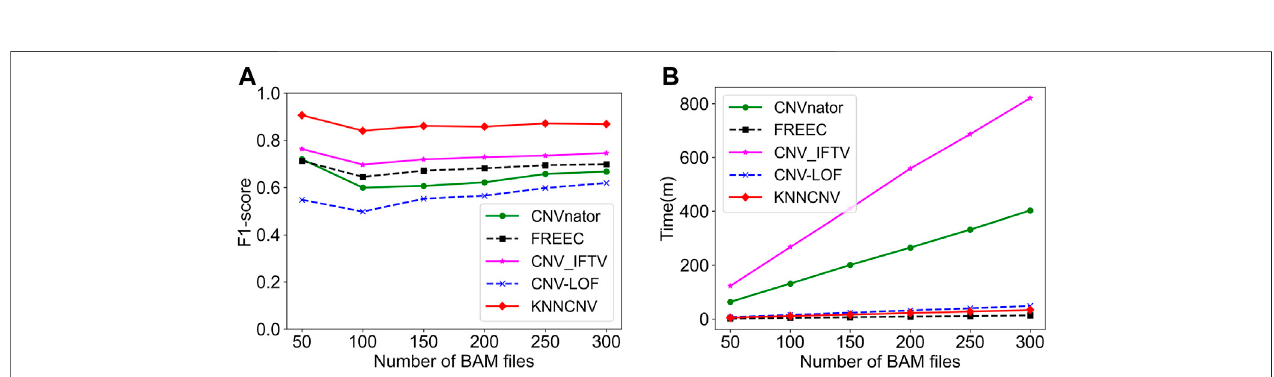
FIGURE 4 | Comparison of the KNNCNV with four peer methods on the simulated datasets in terms of F1-score and computational cost. (A) Performance of the fi ve methods with different the number of BAM fi les. (B) Variation of running time of the fi ve methods with the number of BAM fi les.